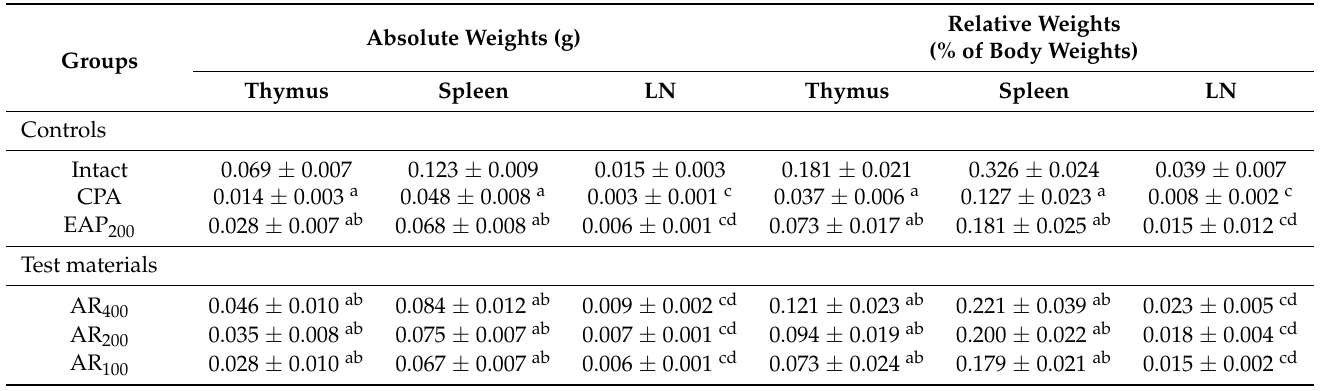
Table 3. Lymphatic organ weights in intact and CPA-induced immunosuppressed